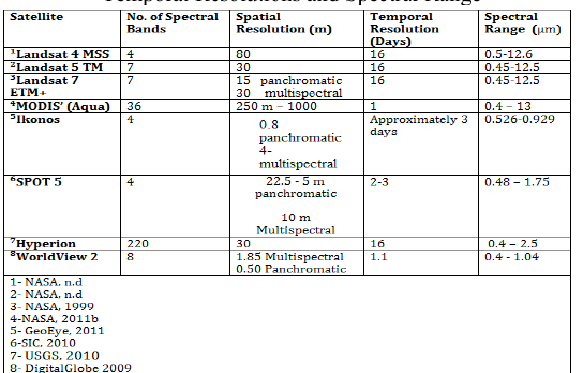
Table 2: Comparison of Satellite Images Spectral, Spatial, Temporal Resolutions and Spectral